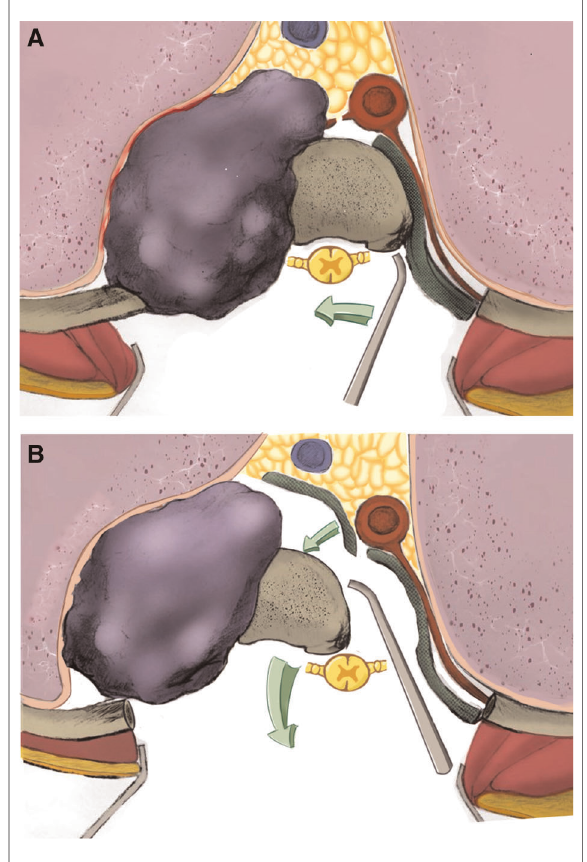
FIGURE 2 Horizontal section of the surgical procedure: ( A ) for the opposite of the mass lateral, the rib(s) connected to the involved vertebrae were cut. Blunt dissection was performed around the lateral and anterior aspects of the vertebral body. ( B ) for the mass lateral, a plane was developed between the multi fi dus and longissimus muscles until the tumor was encountered. Blunt dissection was performed around the lateral and anterior aspects of the mass. The inferior and superior intervertebral discs and anterior longitudinal ligament was cut with scalpel and osteotome. The tumor was turned over and pulled out from the mass lateral of spinal cord.